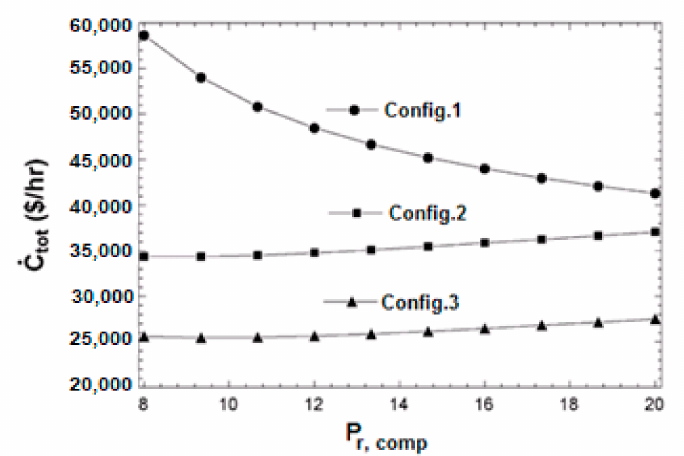
Figure 6. Effect of compressor pressure ratio change on the overall cost